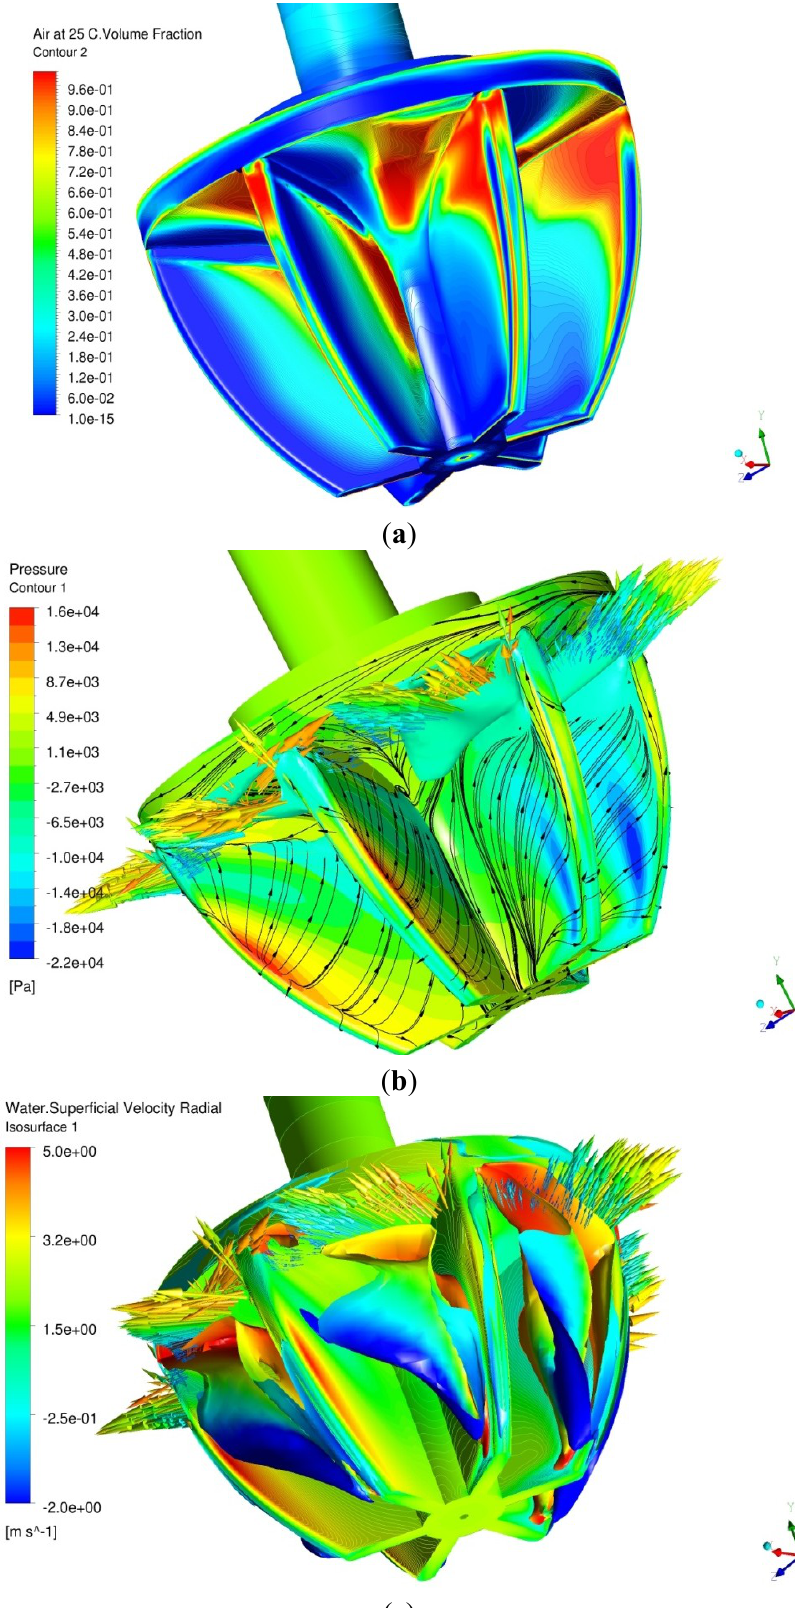
Figure 3. ( a ) Air volume fraction (α) on rotor surface; ( b ) pressure ( P ) contours on rotor surface; ( c ) iso-surface of water superficial relative velocity ( V ( d ) iso-surface of air volume fraction (α = 0.1) showing rotor passage